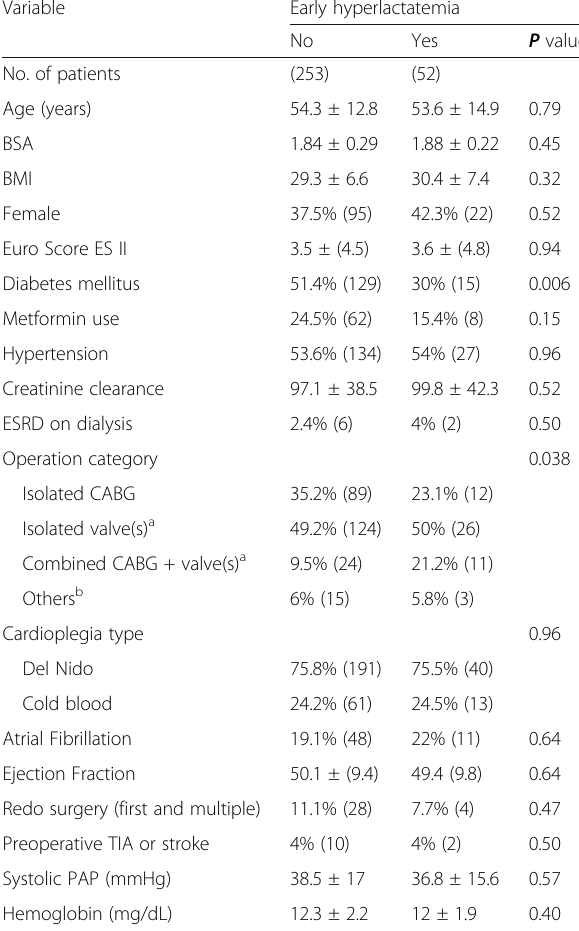
Table 1 Demographics and baseline clinical profile